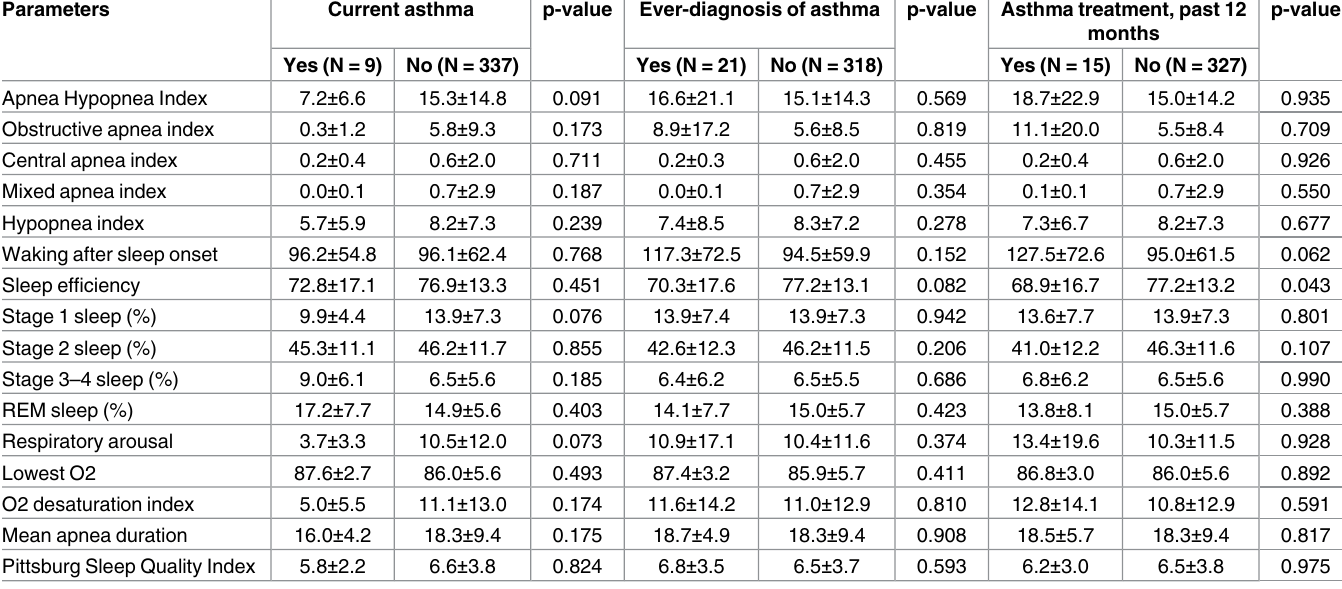
Table 5. Sleep parameters in polysomnography and sleep quality index according to co-morbidity of asthma.